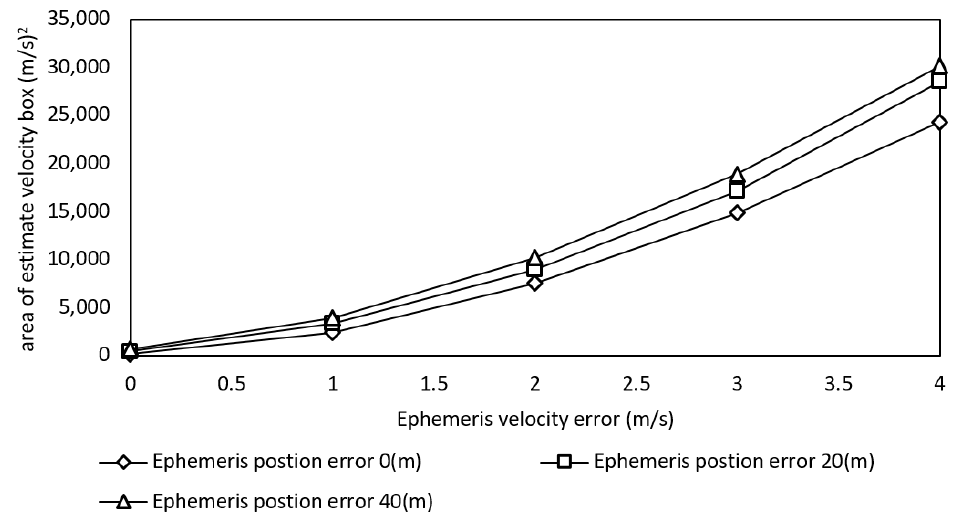
Figure 8. The influence of ephemeris error on the interval area of velocity estimation.